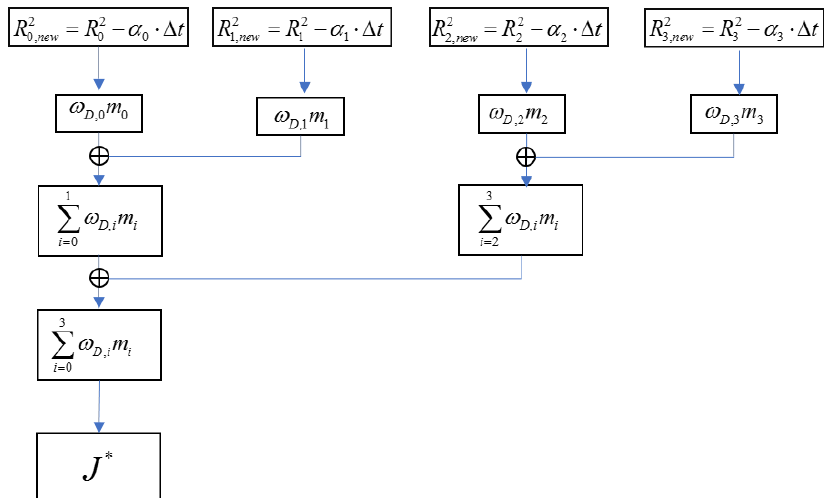
Figure 3. Overview of the parallelization scheme for the droplet